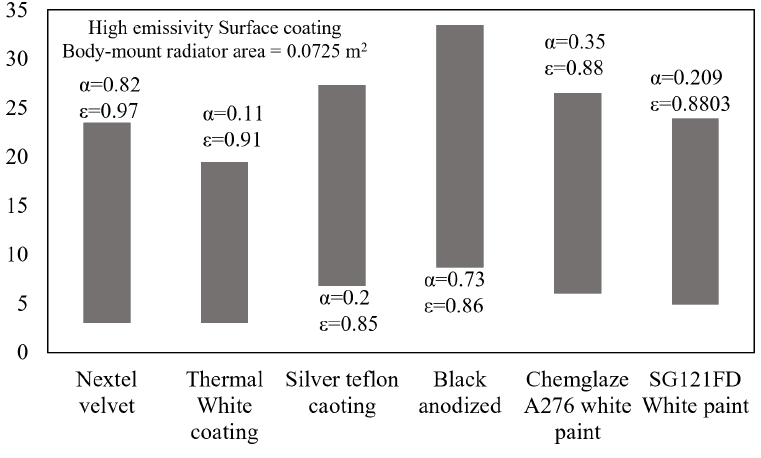
Figure 28. BMR Surface coating